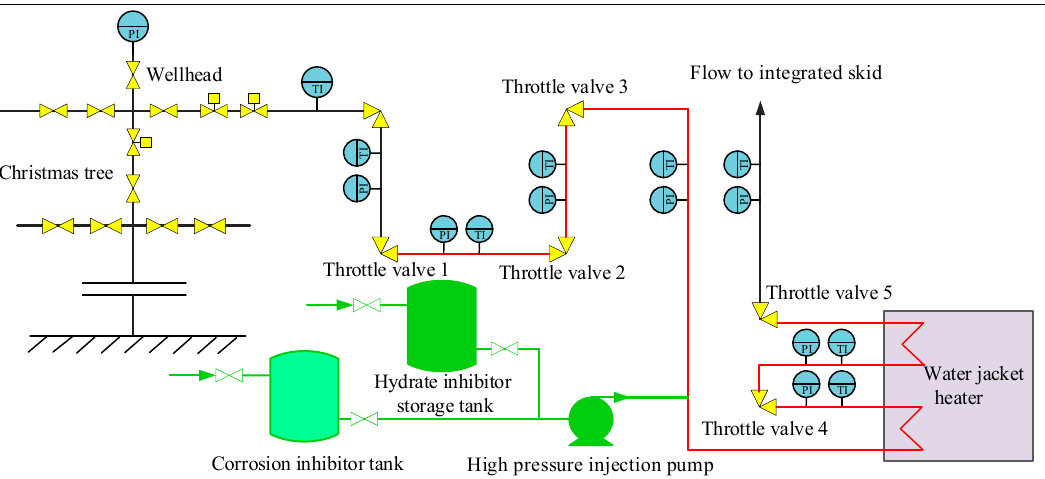
Figure 3. The initial process flow diagram of well L004-X1.